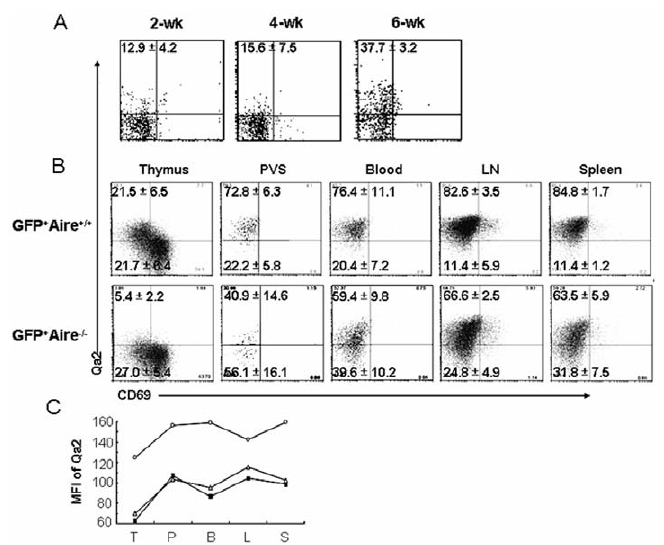
Figure 6. pre-RTEs in the perivascular space upregulate their Qa2 expression. (A) Phenotype of RTEs in Aire -/- mice. FITC intrathymic injection of Aire -/- mice was used to analyze the phenotype of RTEs (FITC + CD4 + CD8 - cells) at 2, 4, and 6 weeks of age. The data from the littermate Aire + / + control mice were shown in Fig. 1A. (B) Phenotype of GFP hi CD4 + CD8 - T cells in RAG2p-GFP and RAG-GFP-Aire -/- mice. GFP hi CD4 + CD8 - T cells from thymus, peripheral blood, lymph nodes, spleen were gated and the expressions of Qa2 and CD69 were analyzed. T cells in the PVS were analyzed by gating at GFP hi PE + CD8 - TCR b + thymocytes 5 minutes after tail vein injection of PE-conjugated CD4 antibody into mice. The numbers in the plot represent the mean and standard deviation of the ratios of Qa2 + CD69 - cells in FITC + , Qa2 + CD69 - cells or Qa2 - CD69 - cells in GFP hi CD4 + CD8 - T cells. Three to five mice were analyzed. (C) Mean fluorescence intensity of Qa2 in GFP hi CD4 + CD8 - T cells from various places was compared. T: thymus (GFP hi CD4 + CD8 - Qa2 + CD69 - cells); P: PVS; B: blood; L: lymph nodes; S: spleen. The data represent the analysis of three mice.